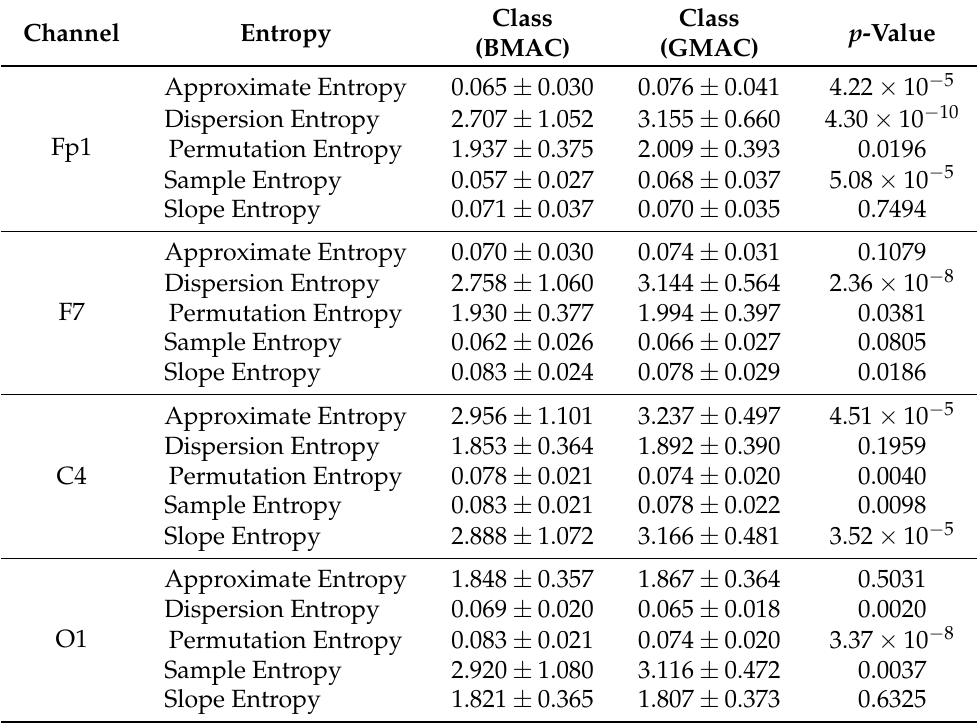
Table 7. The slope entropy features combined with each type of RNN model obtained an average accuracy value of more than 93% when compared to other entropy features. The dispersion entropy features coupled with each RNN model also demonstrated average accuracy values of more than 99% for the sensitivity, precision, and specificity, and the F-score values of each type of RNN model were high using slope entropy features when compared to other entropy features extracted from multi-channel EEG signals. The classification performance of the LSTM, BLSTM, and GRU models was evaluated using the entropy features of each EEG channel, and this is shown in Table 8. The entropy features evaluated using the O2, Fz, Cz, and Pz channel EEG signals obtained average accuracy values of more than 84% using each type of RNN model when compared to the entropy features of other EEG channels. Therefore, the O2, Fz, Cz, and Pz EEG channels were found to be significant for the classification of mental arithmetic tasks. Table 4. Statistical analysis of the entropy features obtained for the Fp1, F7, C4, and O1-channel EEG signals for the automated classification of the BMAC and GMAC